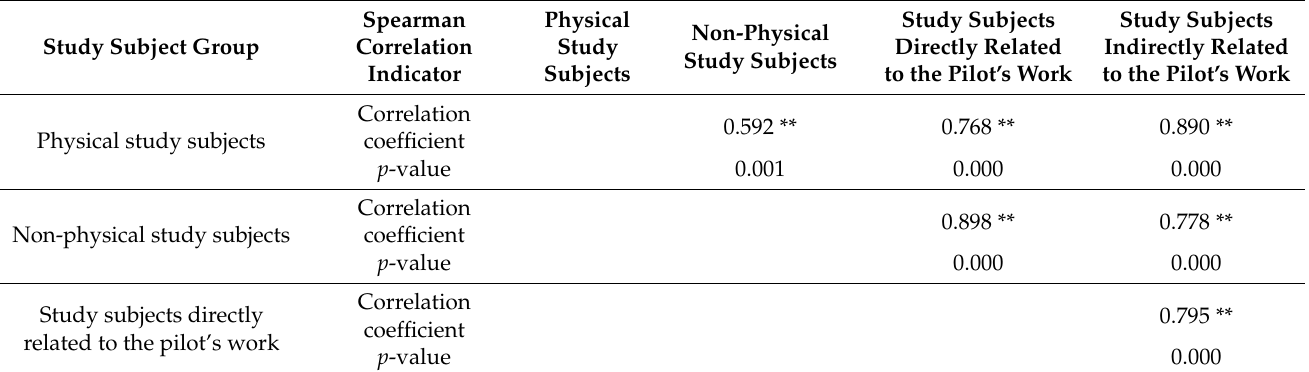
Table 4. Connections between the assessment results in different study subjects for pilots (source: created by the authors).